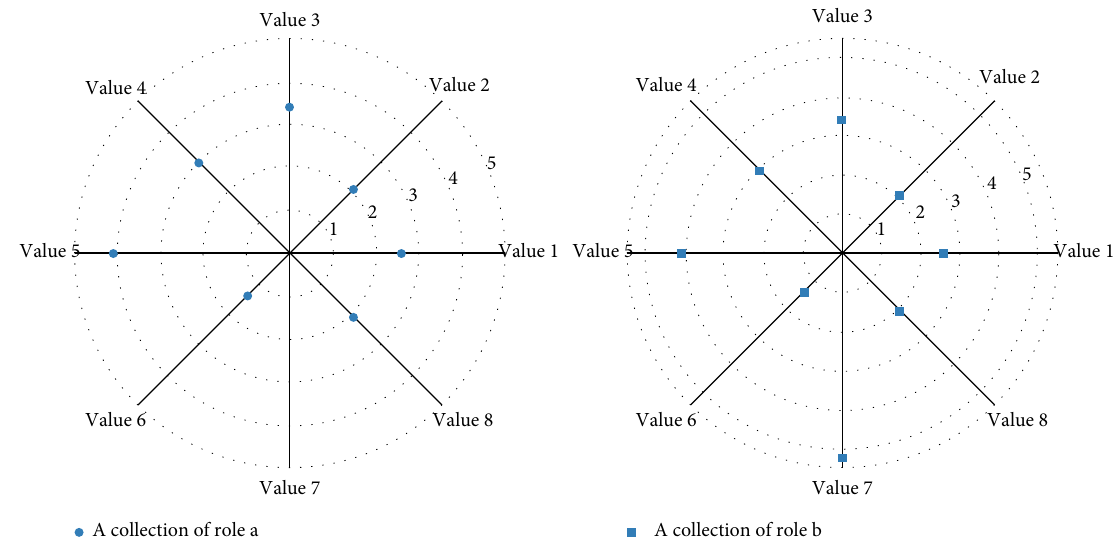
Figure 1: Polarization distribution of role cognitive variable